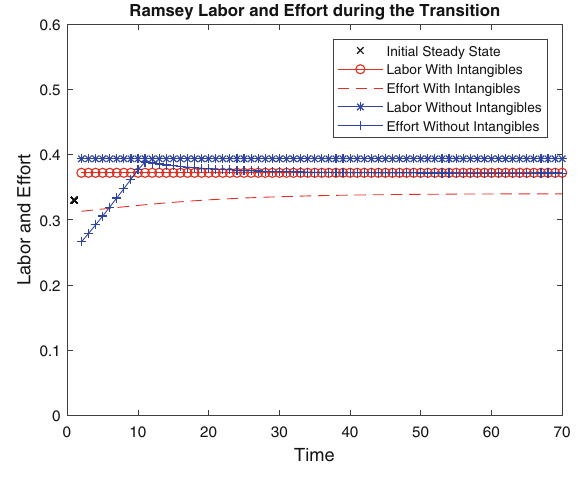
Fig. 6 Labor and effort during the